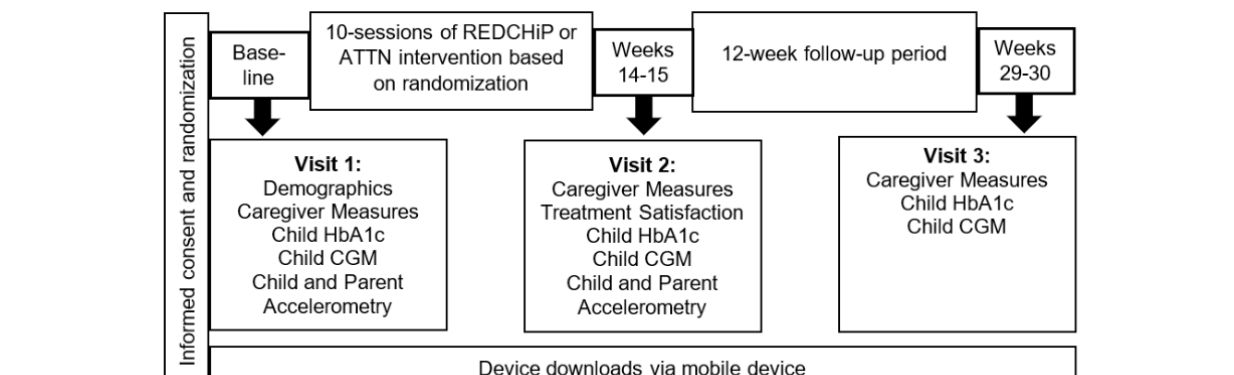
Figure 2. Participant